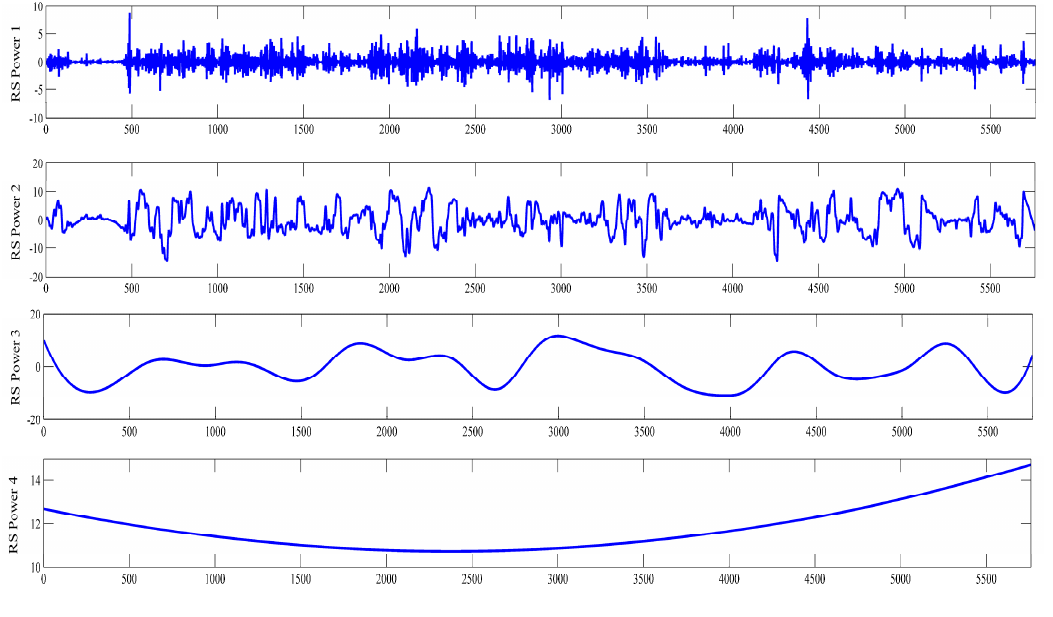
Figure 7. Decomposition results by EEMD-PE. Table 2. Setting the experimental parameters.